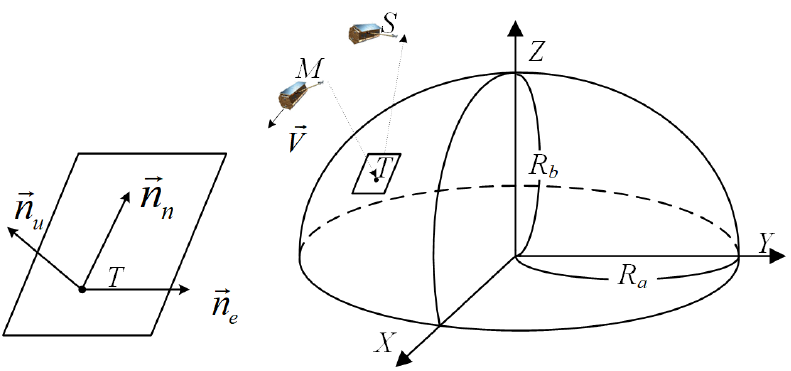
Figure A1. The geometric relationship when acquiring the interferometric data. R a and R b are the semi-major and semi-minor axes of the Earth model,